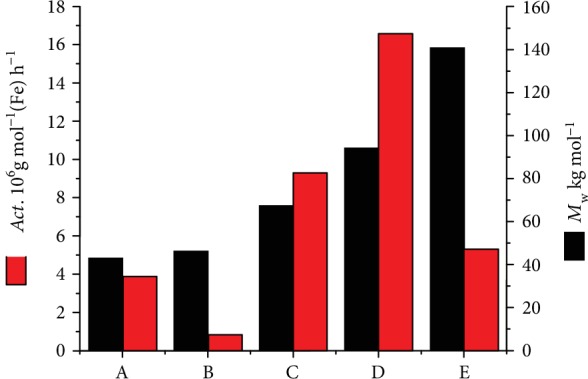
Comparative catalytic performance of EMe2Ph (Fe1) with iron precatalysts AMe2Ph, [4] BMe2Ph [31], CMe2Ph [32], and DMe2Ph [36] (Figure 1); all runs conducted using MMAO, PC2H4 = 10 atm and at 40°C.